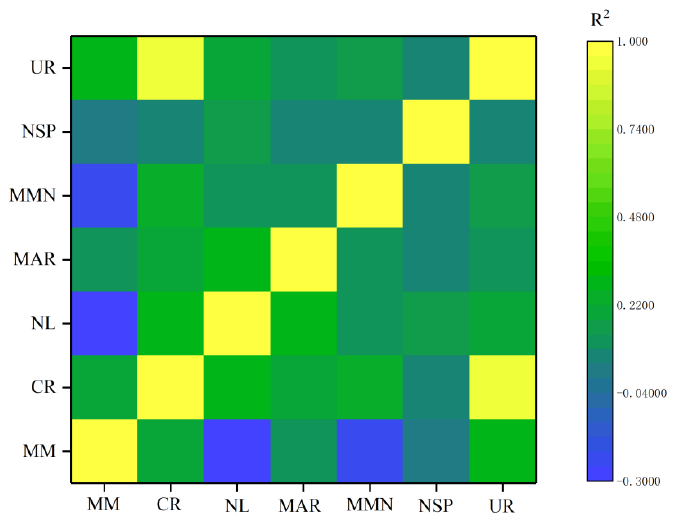
Figure 2. Correlation coefficient between the features.